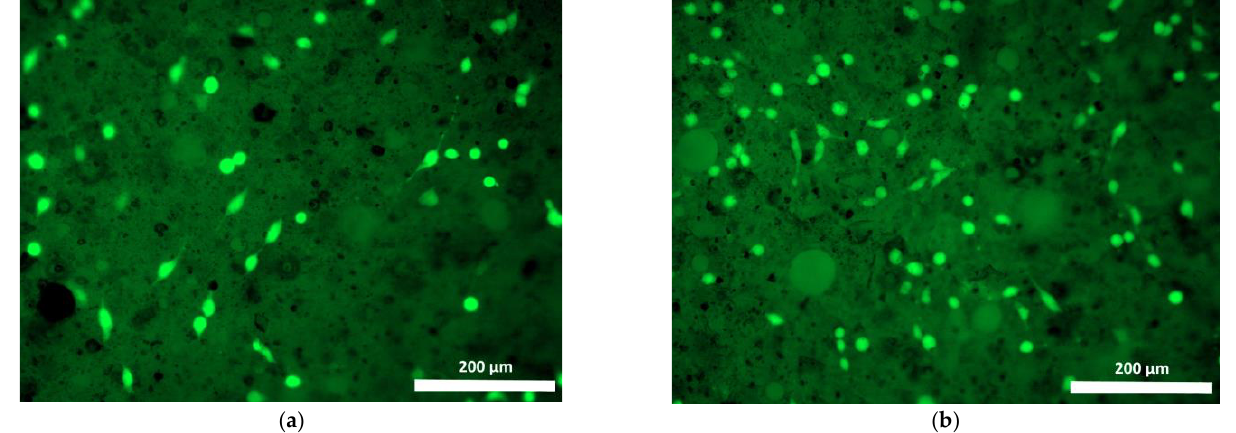
Figure 12. Viable fibroblasts on the surface of Composition 4 specimen (fluorescence microscopy, fluorochrome — Calcein AM (BD Pharmingen ™ ): ( a ) 24 h cultivation; ( b ) 72 h cultivation. Mag.100×.